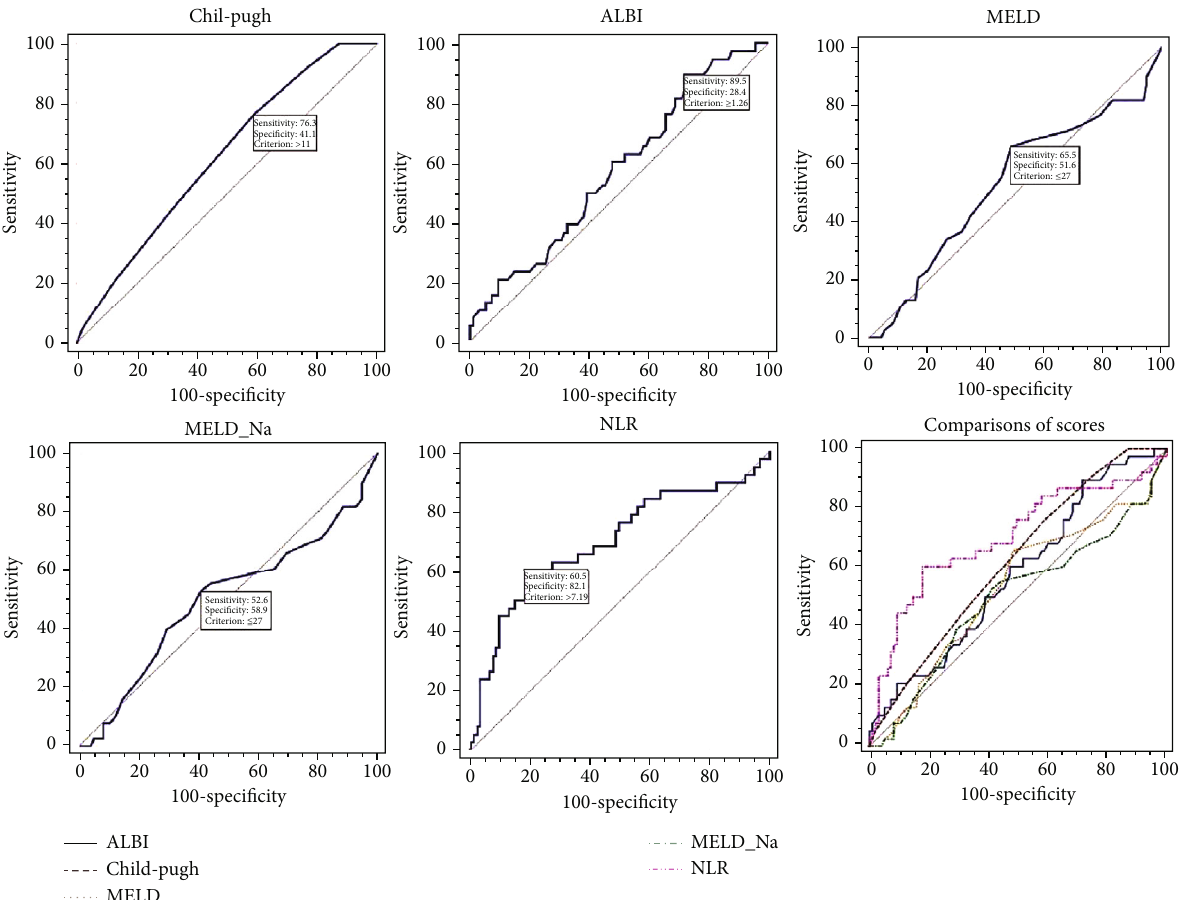
Figure 2: Comparisons of scores in the prediction of in-hospital mortality in the acute-on-chronic liver failure (Table 3). Statistical di ff erences were observed in the Child- Pugh class/score ( p < 0 : 001 ), ALBI grade ( p = 0 : 044 ), MELD score ( p = 0 : 043 ), and NLR scores ( p = 0 : 015 ) between the Figure 2). NLR performed superior discriminative ability to